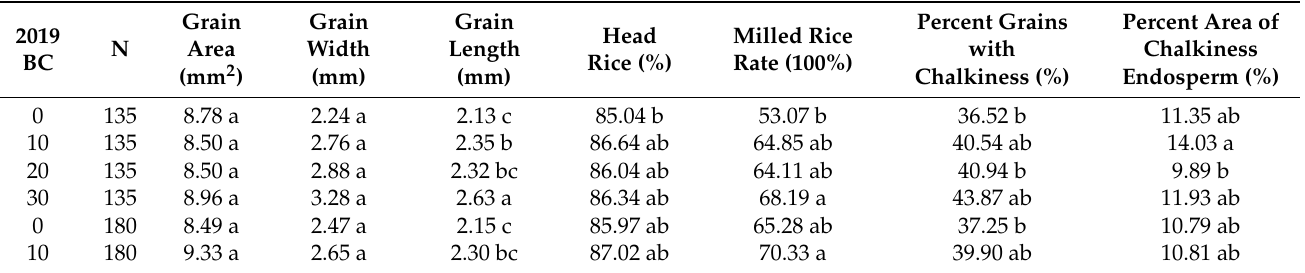
Table 2. The effects of biochar in combination with nitrogen fertilizer on the milling and appearance of grain qualities of